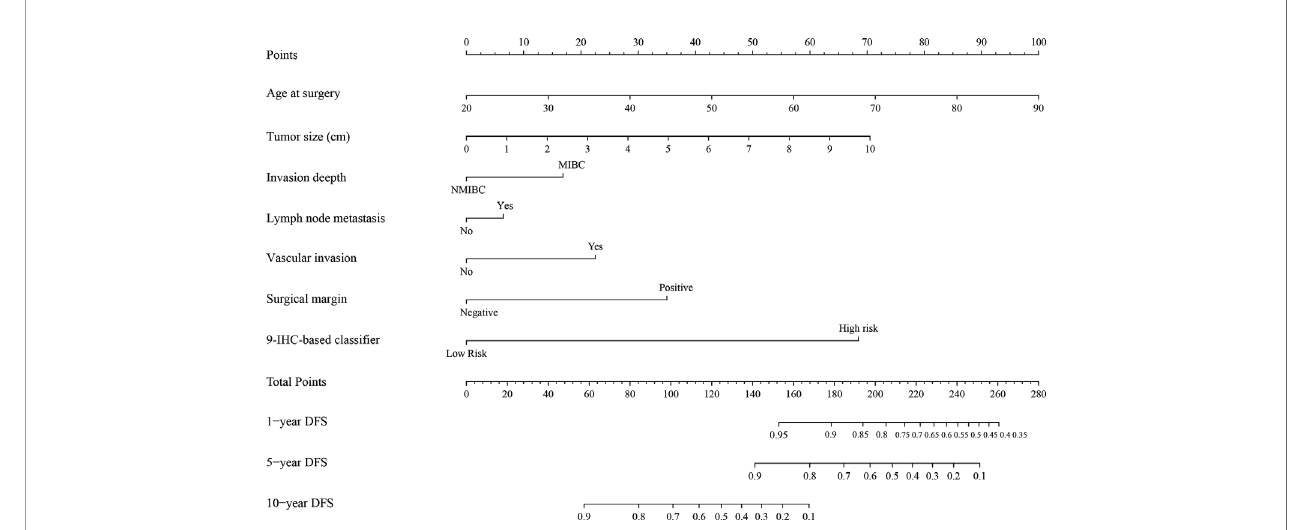
FIGURE 5 | The nomogram for predicting 1-, 5-, and 10-year DFS of bladder cancer patients receiving